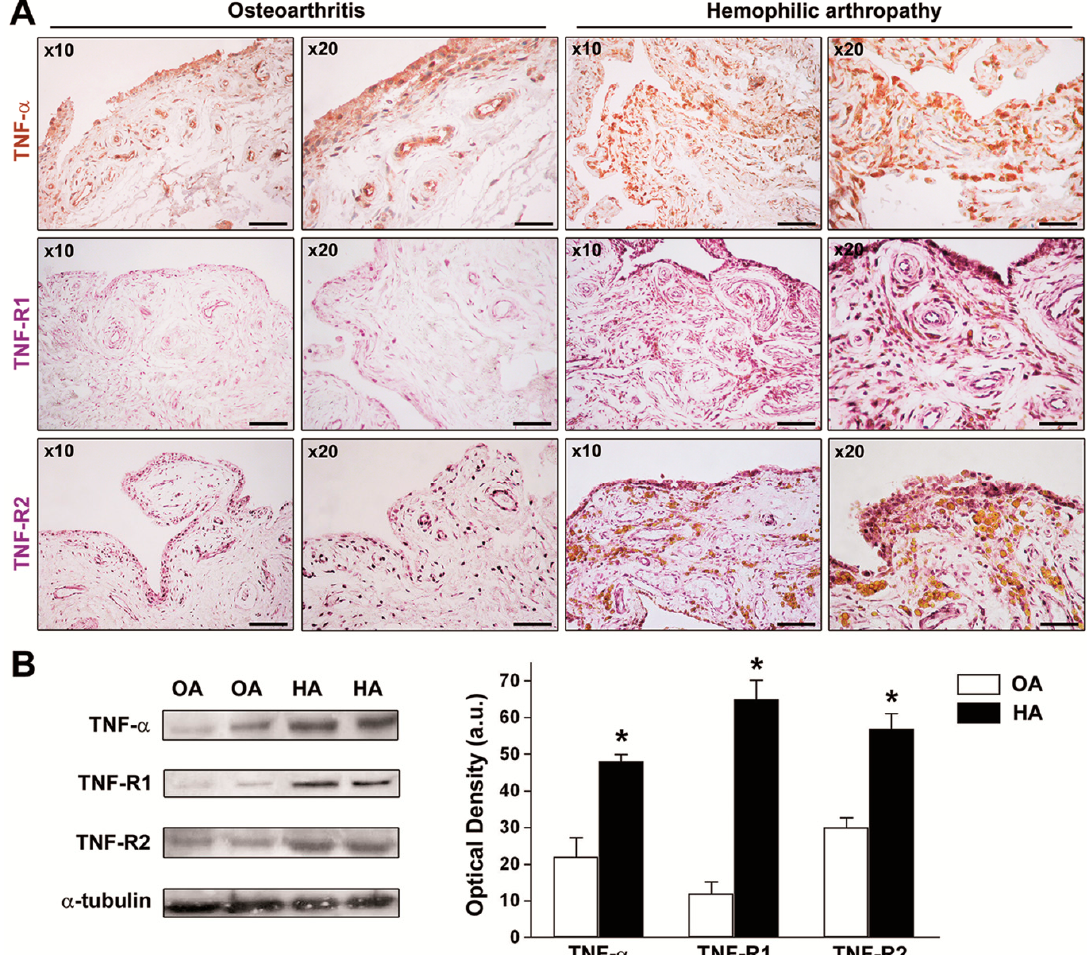
Figure 3. Expression of tumor necrosis factor (TNF)- α , TNF receptor 1 (TNF-R1), and TNF receptor 2 (TNF-R2) in synovial tissue from patients with hemophilic arthropathy (HA) and osteoarthritis (OA). ( A ) Representative microphotographs of tissue sections subjected to immunoperoxidase-based immunohistochemical staining for TNF- α (brown color), TNF-R1, and TNF-R2 (purple color) are shown. TNF- α , TNF-R1, and TNF-R2 immunostaining is strongly increased either in the hyperplastic lining or in the sublining layers of the HA synovium compared to non-inflamed OA control synovium. Original magnification: ×10 and ×20. Scale bar: 200 μ m (×10 panels), 100 μ m (×20 panels). ( B ) Western blotting of total protein extracts from the synovium of HA patients ( n = 10) and OA controls ( n = 8). Representative immunoblots for TNF- α , TNF-R1, and TNF-R2 are shown. The densitometric analysis of the bands normalized to α -tubulin is reported in the histograms. Data are the mean ± SEM of the optical density in arbitrary units (a.u.). * p < 0.05 vs. OA (Student’s t -test). Elevated protein expression levels of TNF- α , TNF-R1, and TNF-R2 were retained in vitro by cultured HA fibroblast-like synoviocytes ( p < 0.05 vs. OA fibroblast-like synoviocytes for all comparisons) (Figure